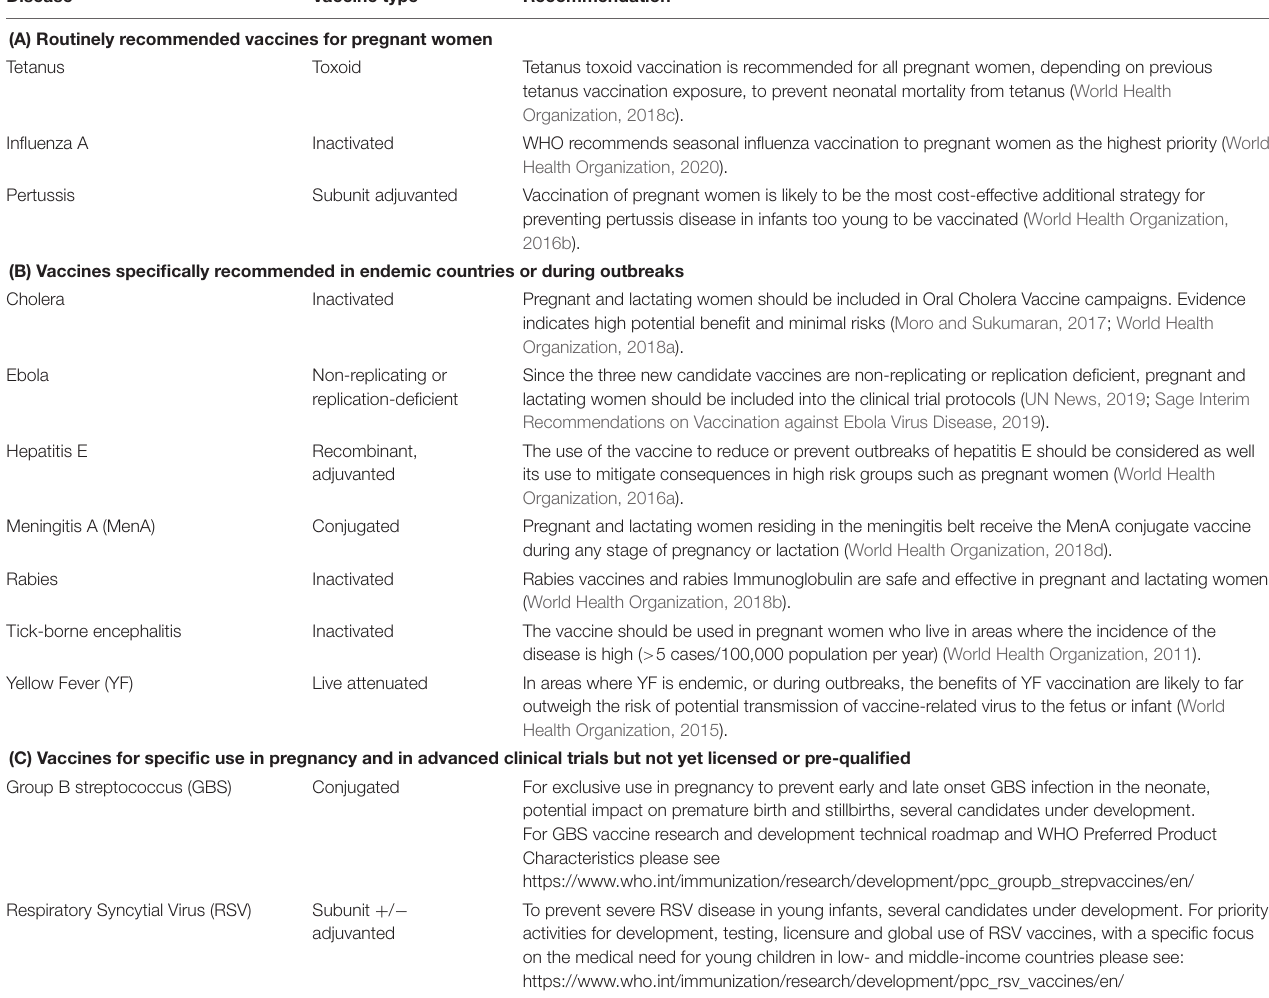
TABLE 1 | Summary of vaccines recommended by WHO for (A) routine use by national programs, (B) use in emergencies or outbreak situations, and (C) in advanced clinical development. Disease Vaccine type